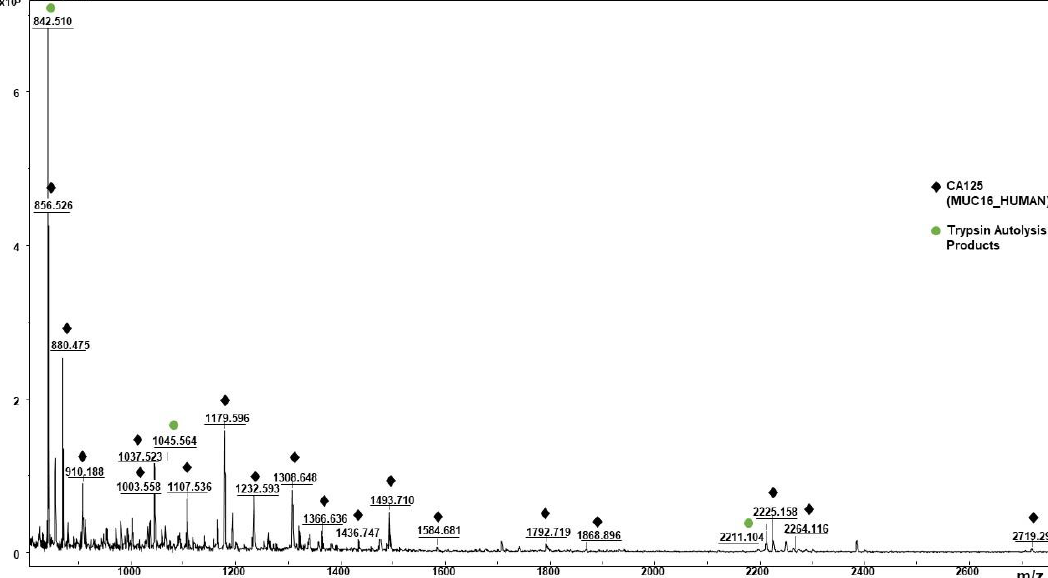
( b ) Figure 5. Typical sensogram curves obtained upon the detection of CA 125 protein in buffer solution at various concen- trations of the target protein, using n-type nanoribbon sensor chips with covalently immobilized aptamers ( a ). Typical sensogram curve, obtained upon the analysis of protein-free solution ( b ). Experimental conditions: 1-mM potassium phos- phate (KP) buffer, pH 7.4, V g = +50 V; V d s = 0.2 V. The total volume of the solution in the cell was 450 μL. Arrows indicate addition of the CA 125 solution (with concentrations from 2 aM to 2 fM, as indicated in ( a )) and washing with pure protein- free KP buffer.